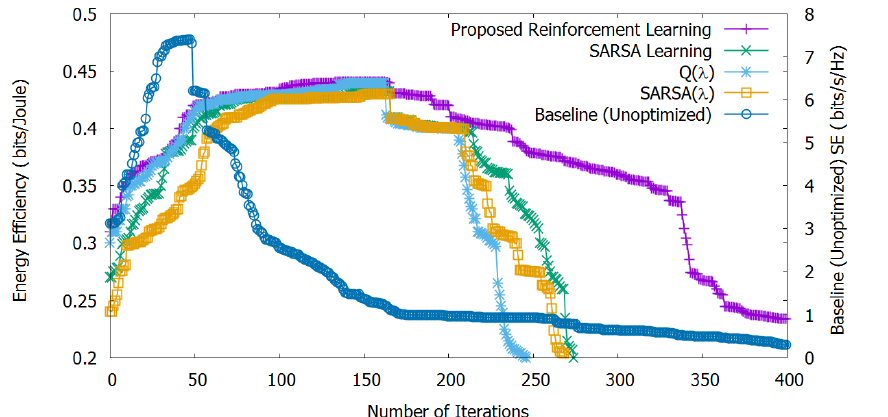
Figure 4. Stand-alone energy efficiency performance evaluation and non-optimized spectral efficiency. The proposed method helps to increase Energy Efficiency (EE) until 160 iterations; afterwards, energy efficiency progressively decreases due to the increasing number of depleted